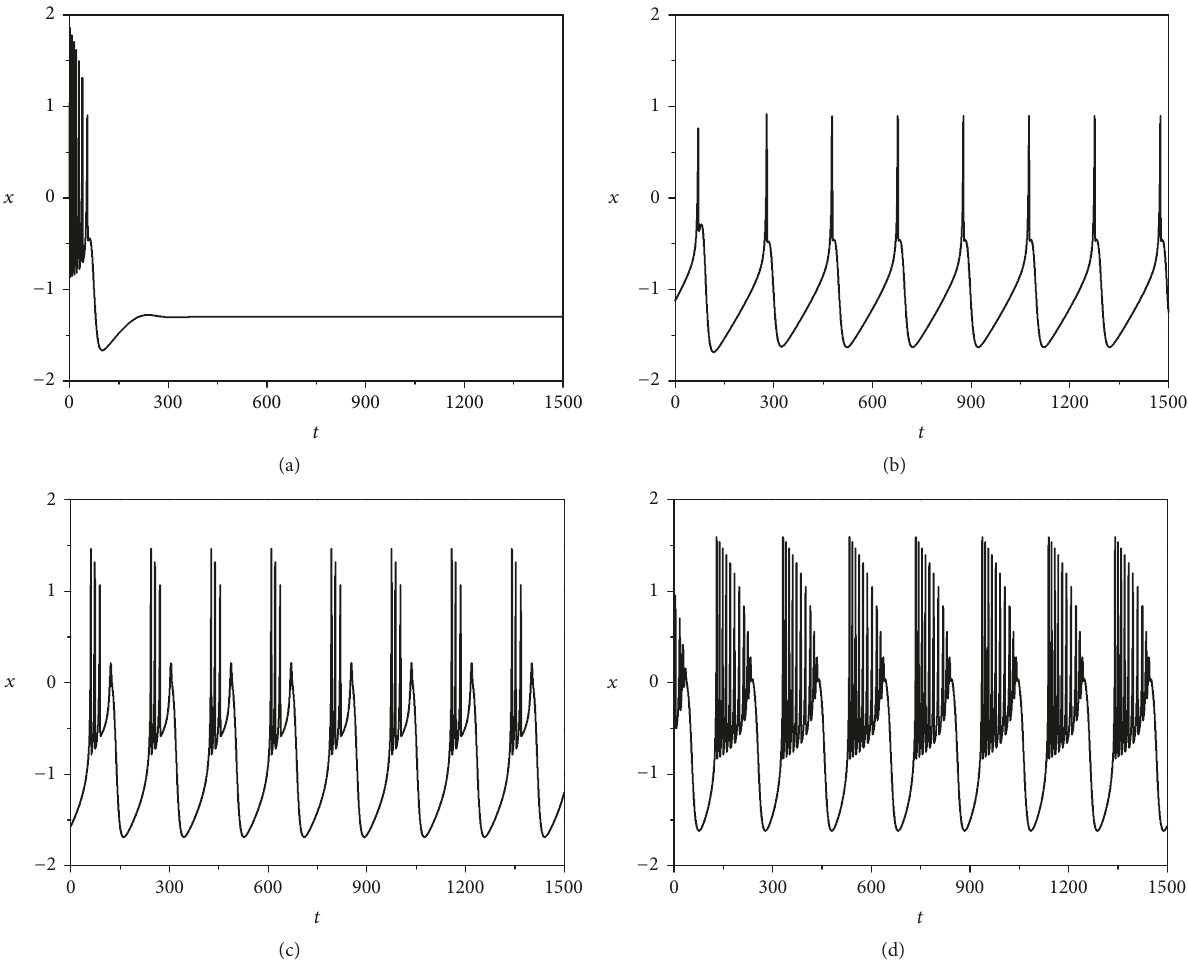
Figure 2: Sampled time series of membrane potential under different external direct current 𝐼 ext . (a) 𝐼 ext = 1.0 . (b) 𝐼 ext = 1.5 . (c) 𝐼 ext = 2.3 . (d) 𝐼 ext = 3.5